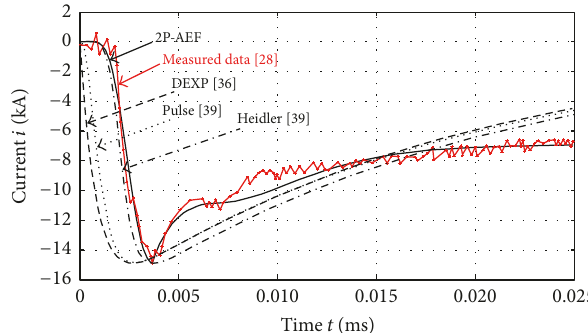
Figure 14: Normalized typical negative first stroke current [1] and its approximations by DEXP, Pulse, Heidler’s function, and 2P- AEF(2,1,2).